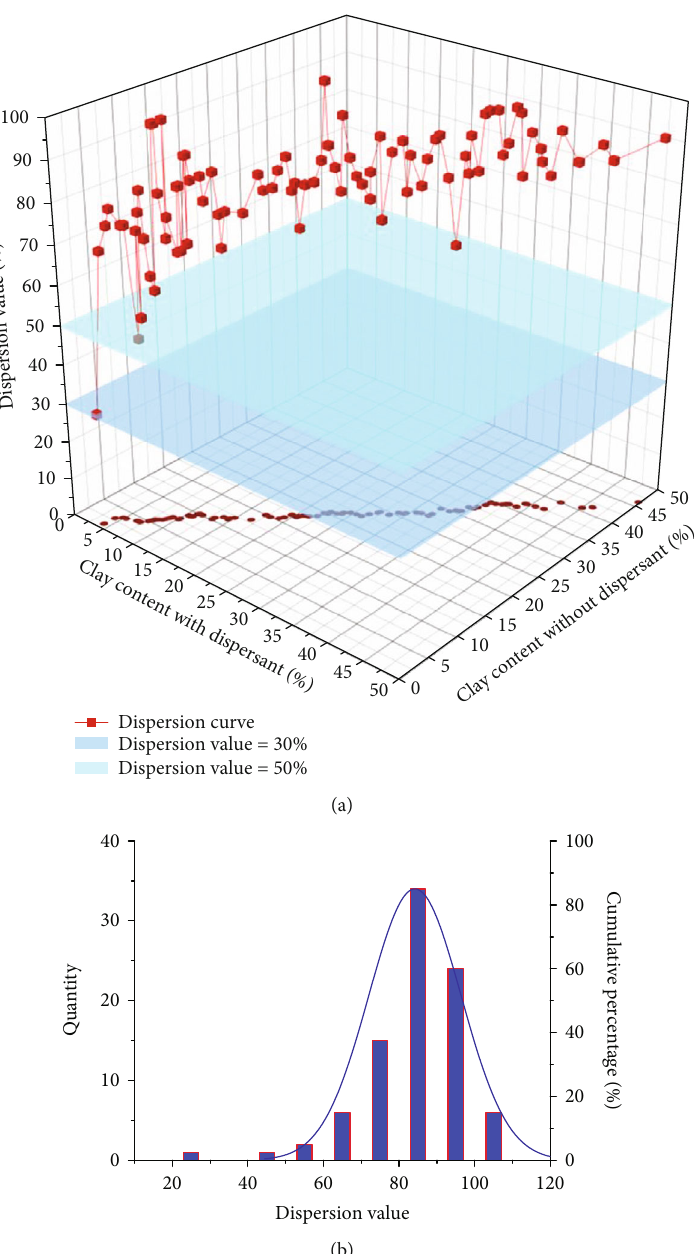
Figure 9: Results of the double hydrometer experiment: (a) comparison of the clay content under the two test conditions; (b) curve of the dispersion